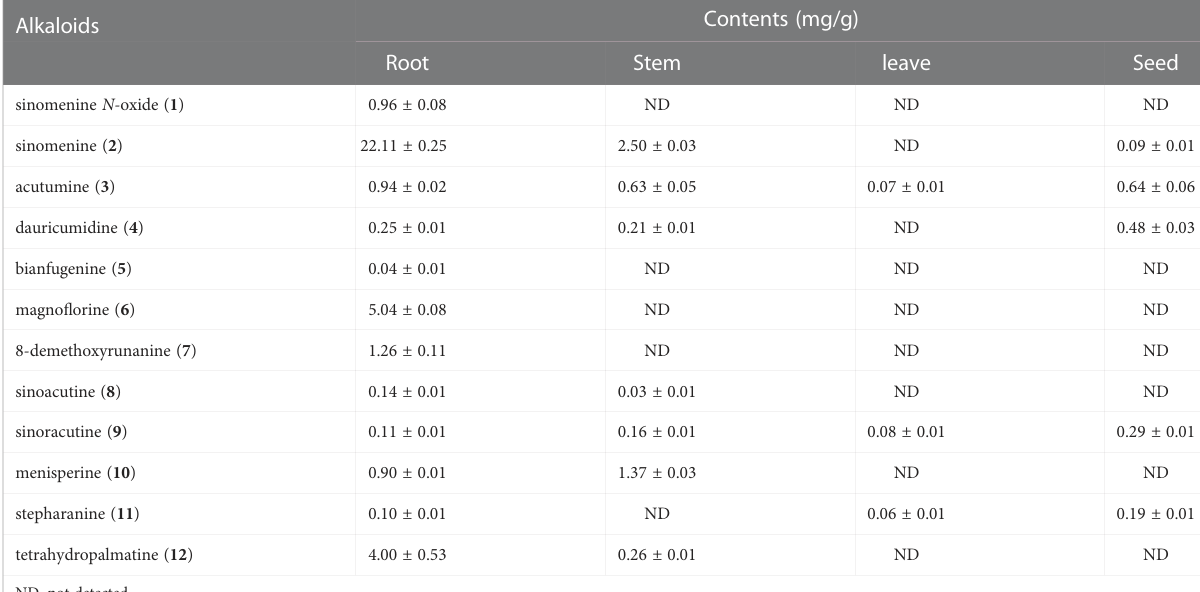
TABLE 1 The BIA contents in different tissues of S. acutum